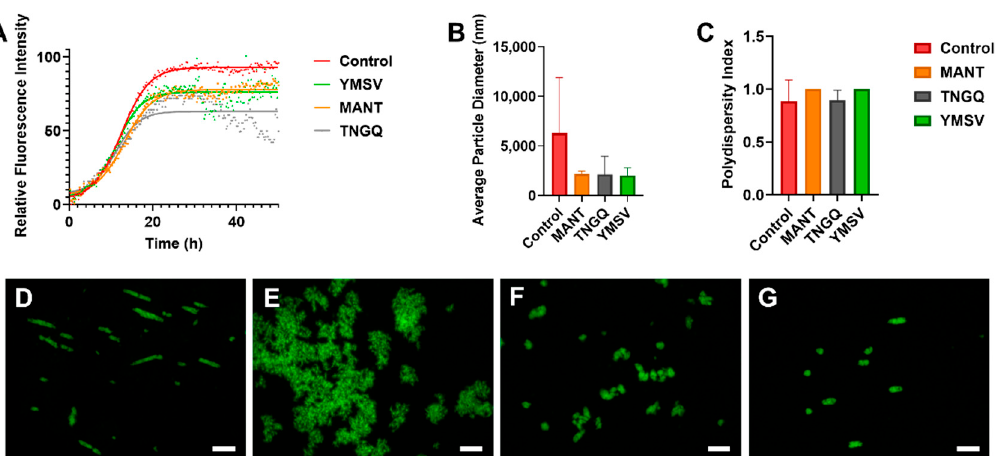
Figure 1. ( A ) Thioflavin-T fluorescence kinetics of IAPP fibrillation in the absence (control) and presence of tetrapeptides MANT, TNGQ, and YMSV. ( B ) Average particle size diameter (nm) and ( C ) polydispersity index of IAPP in the absence (control) and presence of MANT, TNGQ, and YMSV in the late stationary phase of fibrillation. ThT fluorescence microscopy of IAPP in the ( D ) absence (control), and presence of peptides ( E ) MANT, ( F ) TNGQ, and ( G ) YMSV. Scale bars represent 50 µ m. Table 1. Physicochemical properties and fibrillation kinetic parameters derived from ThT fluorescence assay of IAPP fibrillation in the absence (control) and presence of tetrapeptides MANT, TNGQ, and